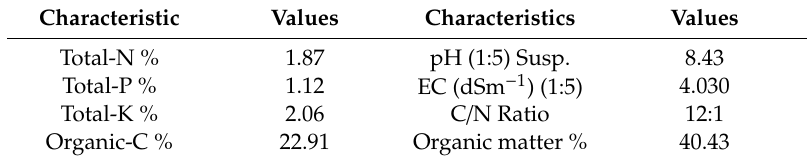
Table 2. Chemical composition of farmyard manure used in the experiments on dry weight basis. Characteristic